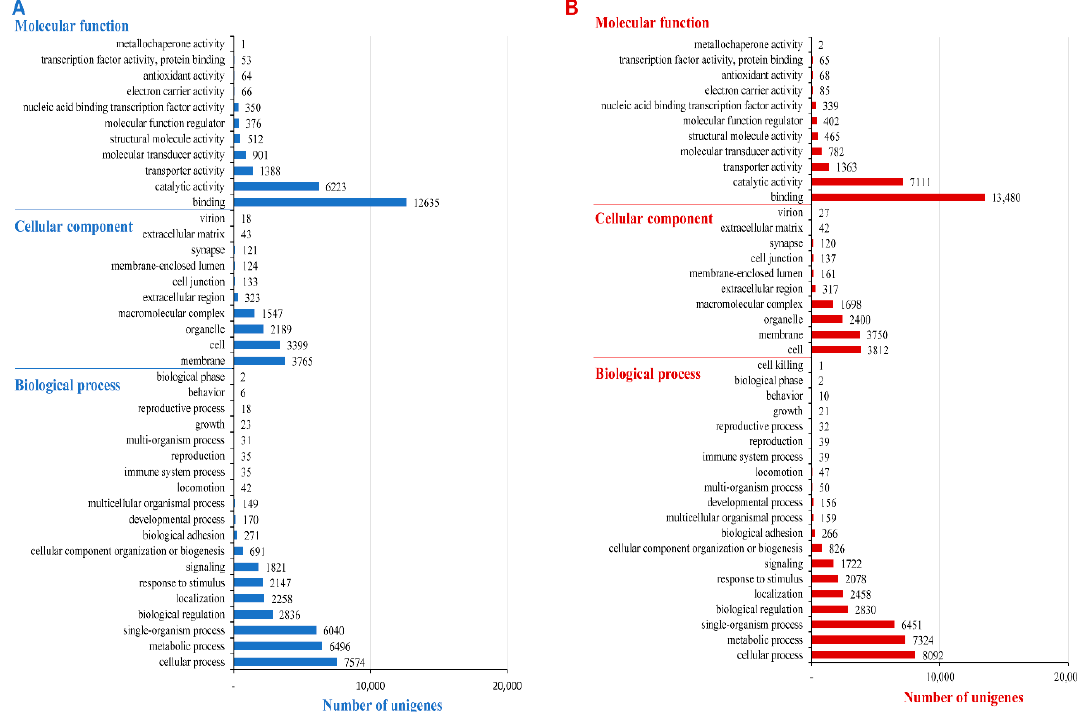
Figure 9. GO functional classification at level 2 for A. chejuensis ( A ); and A. quelpartensis ( B ) unigenes.